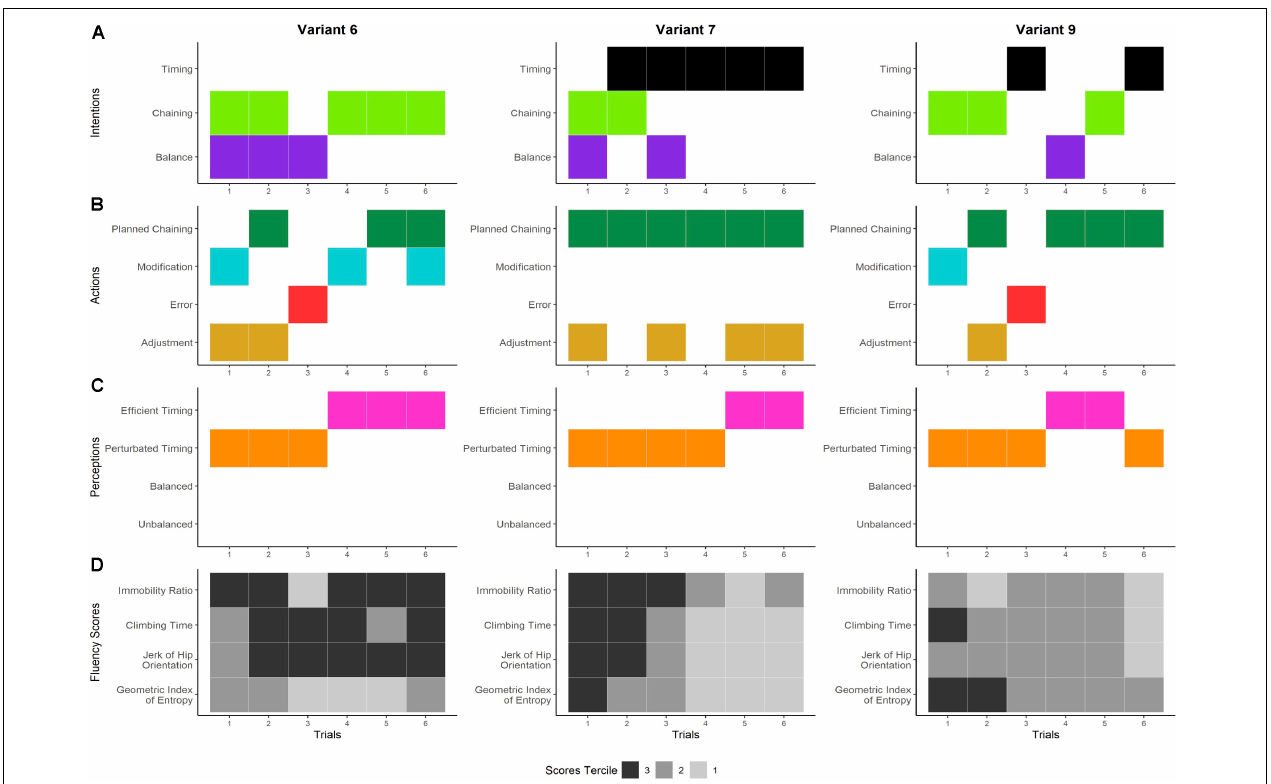
FIGURE 8 | Dynamics of the climber’s experience and performances on variants 6, 7, and 9. Panels A–C show the temporal organization of the general dimensions of the components of experience detected during the interviews. Panel A shows the general dimensions of the climber’s intentions: seeking and maintaining balance while climbing (purple), ensuring the correct execution of movement chaining (light green), and improving the timing of the climb (black). The climber’s actions are shown in panel B: Adjusting the foot chaining while climbing (gold), making errors while climbing (red), deliberately modifying the planned movements while climbing (light blue), and carrying out the planned chaining (dark green). Panel C shows the general dimensions of the climber’s perceptions: sensation of being balanced (dark blue), sensation of being unbalanced (green), sensation of efficient timing (pink), and sensation of perturbed timing (orange). Panel D shows the score terciles for each fluency indicator. The climbing performance is expressed in the terciles: tercile 3 (in black) refers to his poorest performances, tercile 2 (in dark gray) refers to his intermediate performances, and tercile 1 (in light gray) refers to his best